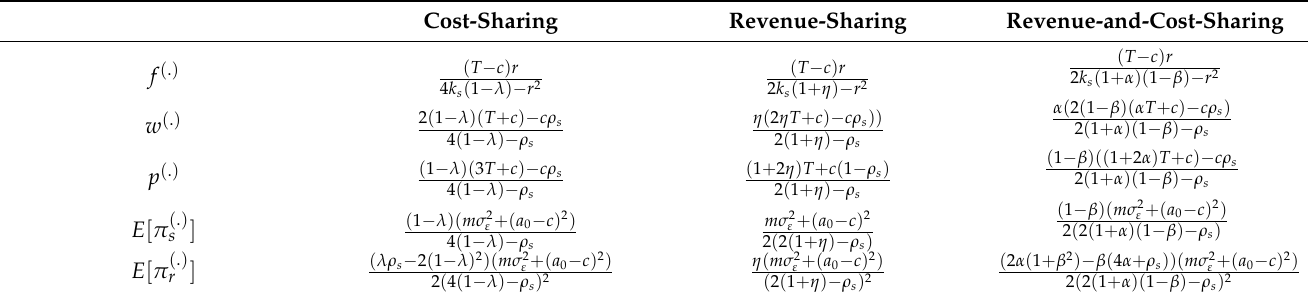
Table 4. The equilibrium outcomes of the three incentive